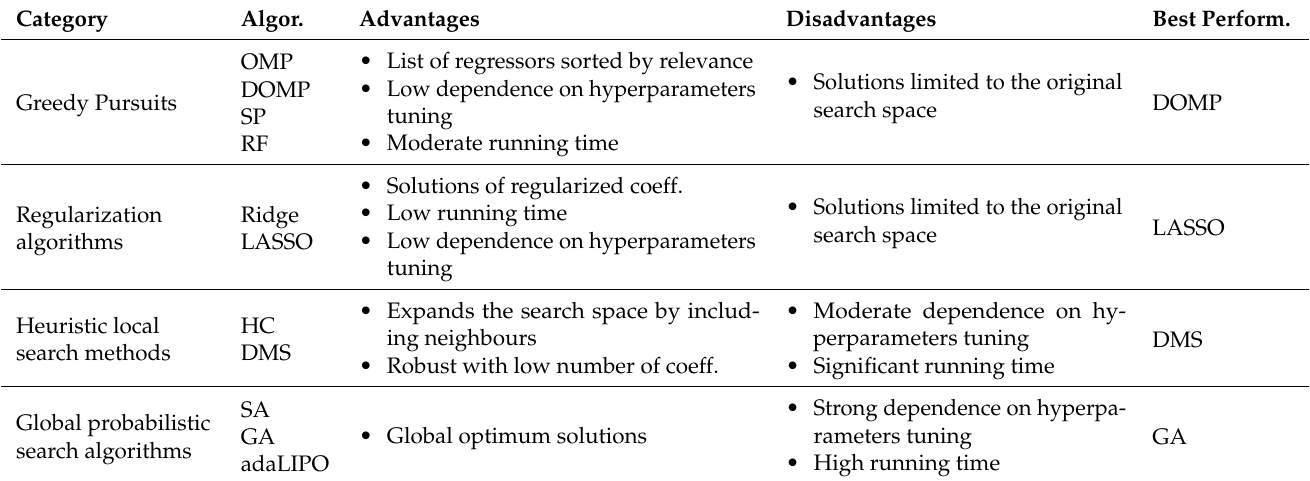
Table 3. Advantages and disadvantages of the feature selection techniques under